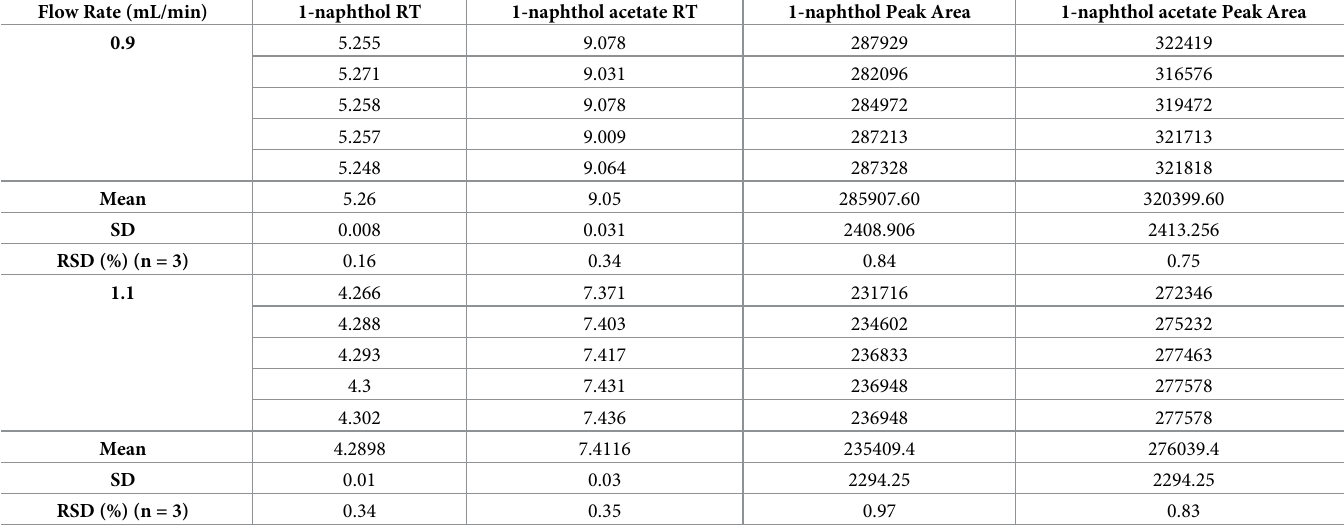
Table 3. Robustness of 1-naphthol and 1-naphthol acetate on the developed method. Flow Rate